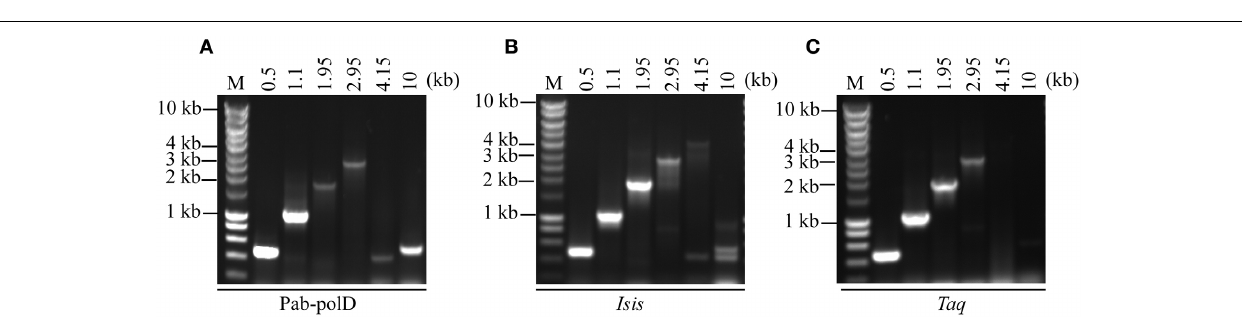
2.95, 4.15, and 10kb ( Table 1 ). PCR programs were (2min at 94 ◦ C) × 1; (1min at 94 ◦ C/1min at 58 ◦ C/2, 4, 6, 8, 11, and 16min with respect to the